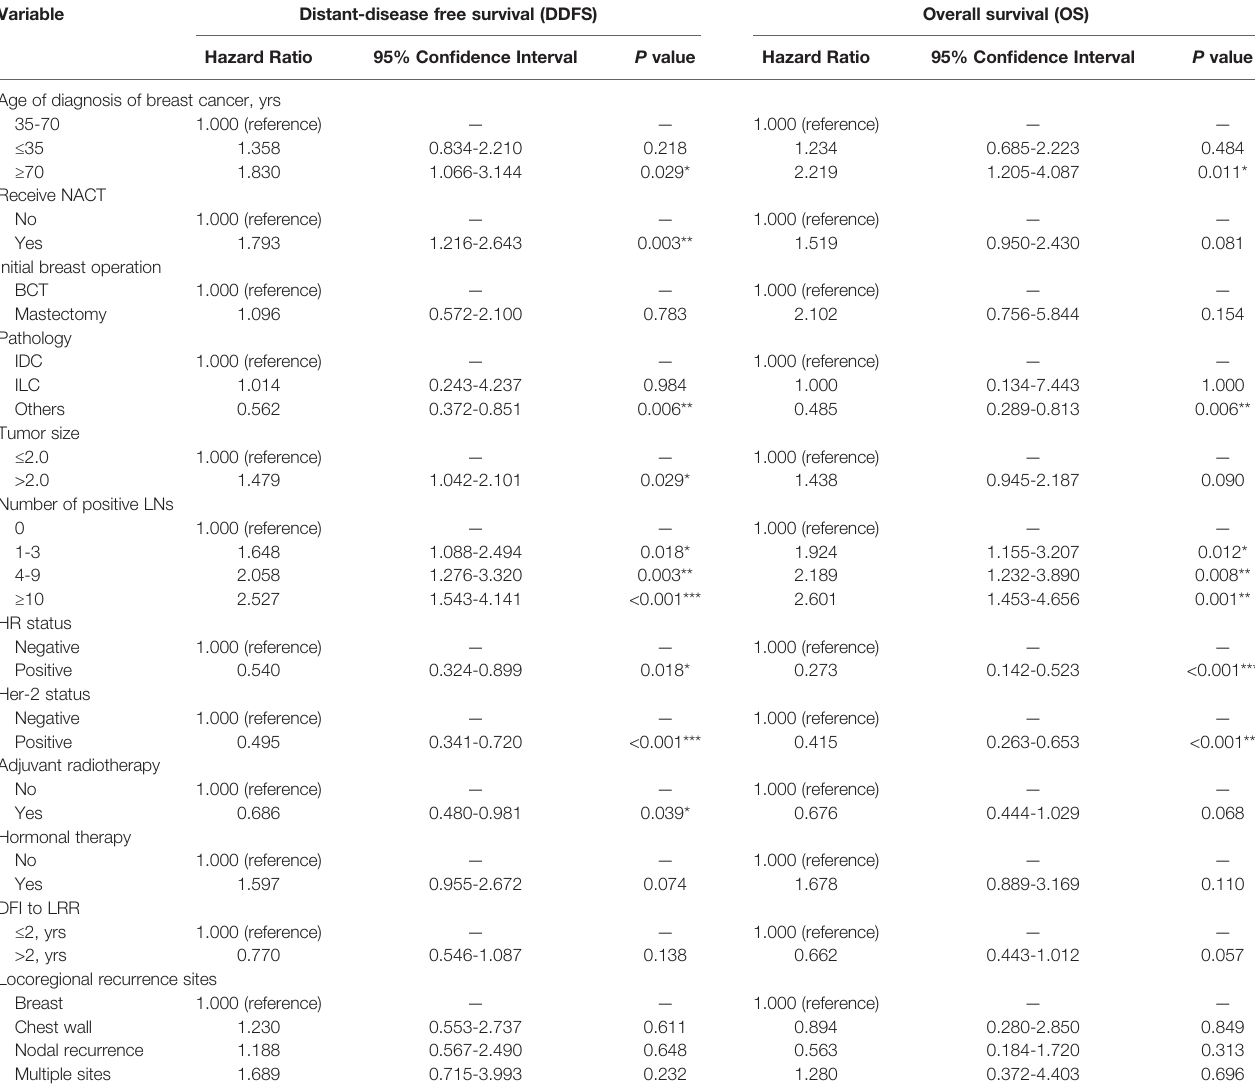
TABLE 2 | Multivariate cox regression analysis of prognostic factors in the training cohort. Variable